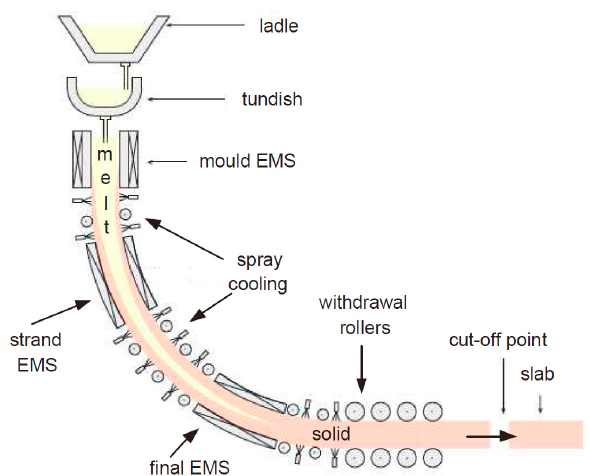
Figure 1. Schematic for the continuous casting of steel.